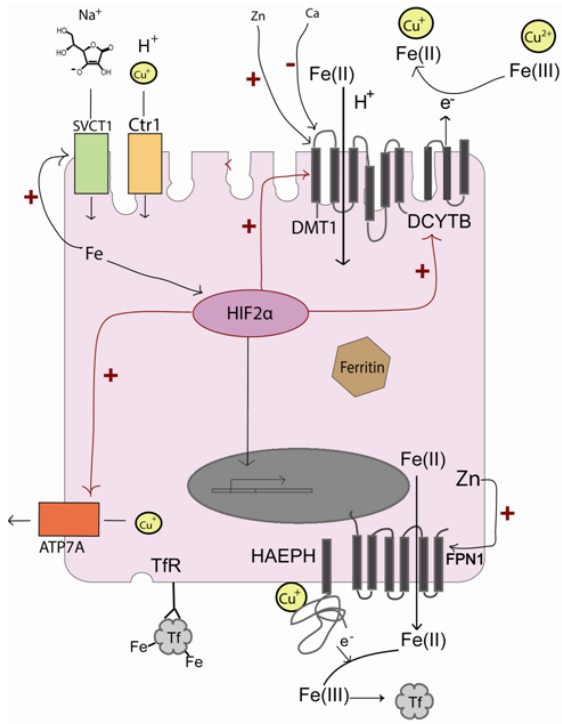
Figure 2. Overview of interactions between Fe, Cu, and ascorbate transporters with the hypoxia transcription factor HIF2α, Fe, Cu, Zn, and Ca in enterocytes. Cu transport and the control of transcription by HIF2α is central for regulation of iron